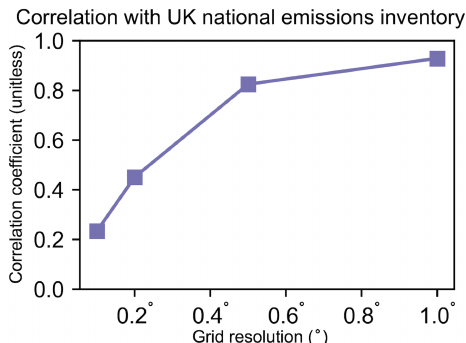
Figure 8. Spatial correlation between gridded United Kingdom emissions in our inventory and in the National Atmospheric Emis- sions Inventory (NAEI; Defra and BEIS, 2019). The figure shows the Pearson correlation coefficient ( r ) at the native 0 . 1 ◦ × 0 . 1 ◦ grid resolution of our inventory and after averaging over coarser grid resolutions up to 1 ◦ × 1 ◦